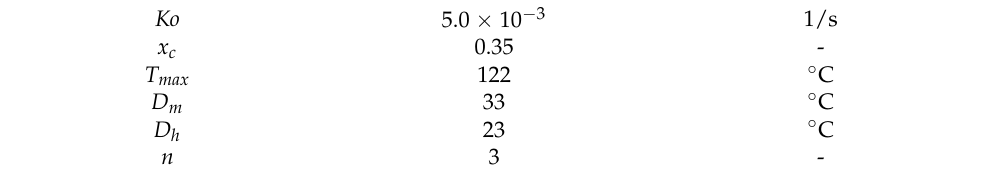
Table 2. Parameters adopted for the description of the crystallization kinetic by the Nakamura approach.